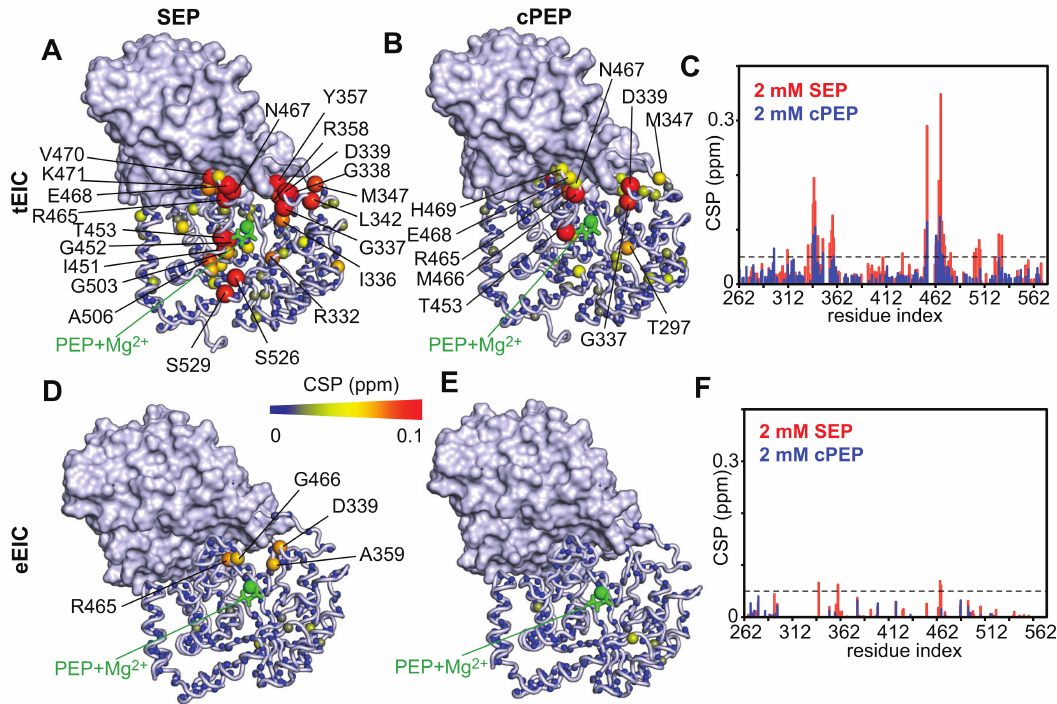
Figure 3. The weighted combined chemical shift perturbations (CSP) induced by ( A ) 2 mM SEP and ( B ) 2 mM cPEP on the 1 H- 15 N TROSY spectrum of tEIC are displayed on the structure of the EIC–PEP complex as spheres with the relationship between size and color of each sphere and the CSP